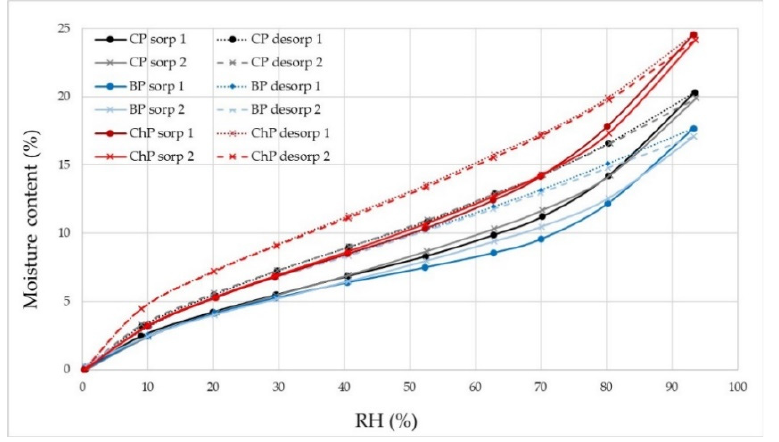
Figure 1. Water sorption isotherms for undegraded and degraded pine wood; sorp—adsorption, desorp—desorption, CP—sound wood, BP—biologically-degraded wood, ChP—chemically-degraded wood.